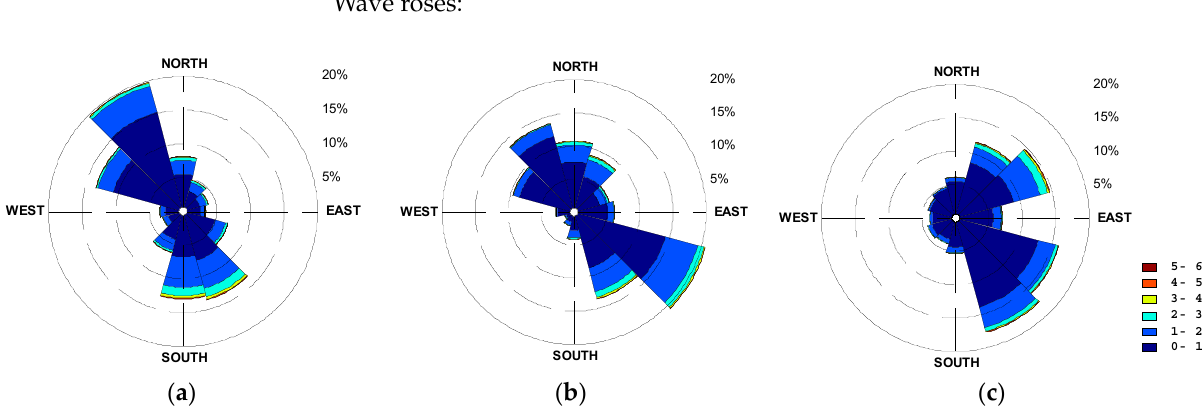
Figure A1. Wave roses for all sea states: ( a ) South Adriatic, ( b ) Central Adriatic and ( c ) North Adriatic.